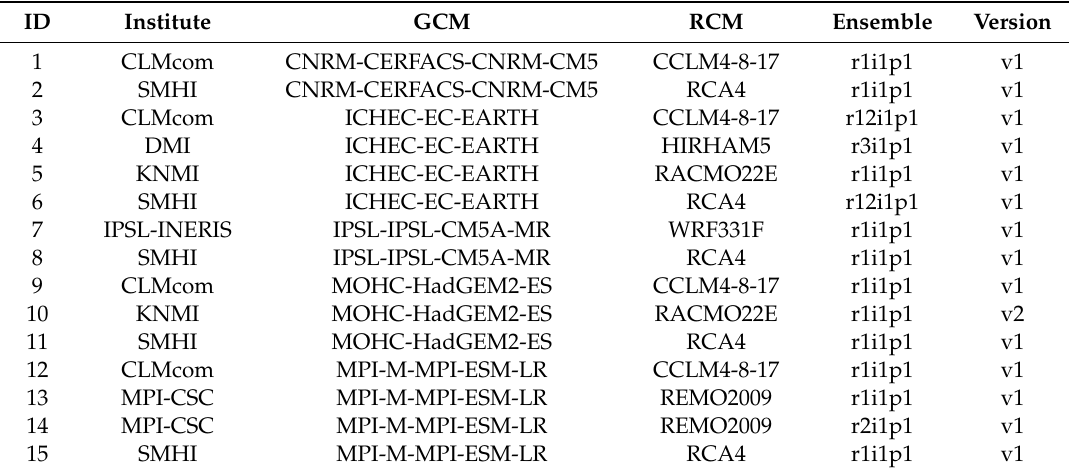
Table 3. The output of climate models used in this study was available for RCP 4.5 and RCP